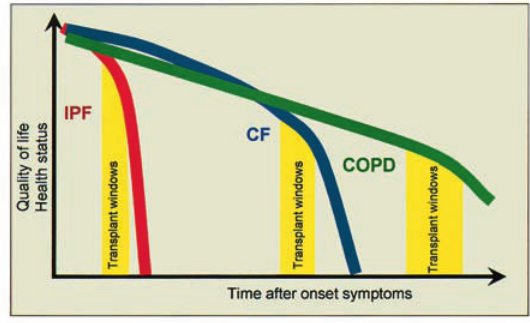
Right time for lTx evaluation depends from several factors, such as underlying disease, disease progression,